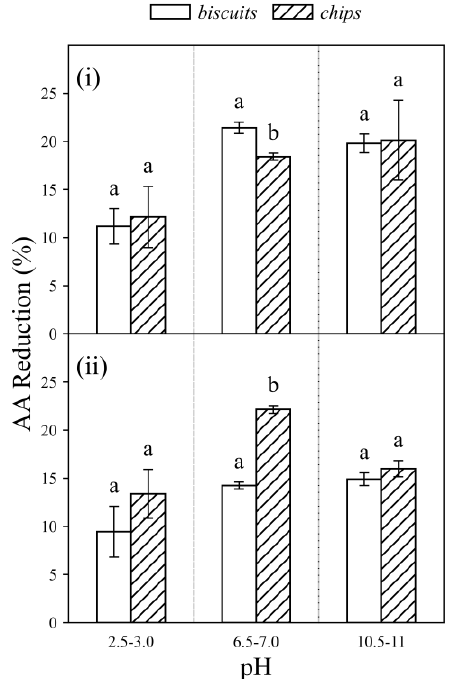
Figure 5. Acrylamide (AA) reduction percentages of ( i ) L. acidophilus and ( ii ) B. longum (10 9 CFU/mL) in spiked food samples (750 ng AA/g food): biscuits and chips at three different pH conditions (pH 2.5 – 3.0, 6.5 – 7.0 and 10.5 – 11.0). Incubated at 37 °C for 4 h. Different characters in each panel indicate significant differences, whereas same character indicates no significant difference.